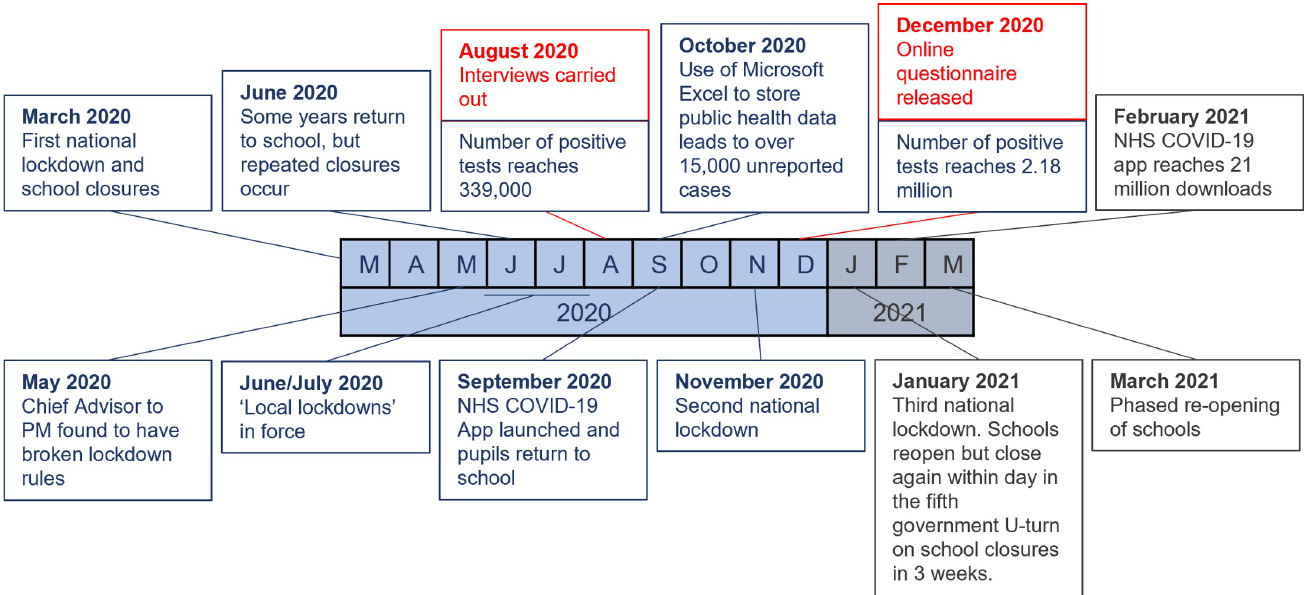
Fig 1. A year of COVID-19 restrictions in the UK. A summary of events in the UK surrounding COVID-19 between March 2020 and March 2021, with the timing of the Interview and Questionnaire studies included.